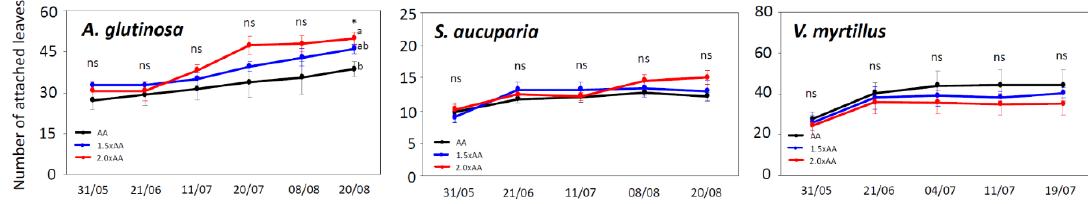
Figure 4. Number of attached leaves in Alnus glutinosa , Sorbus aucuparia, and Vaccinium myrtillus exposed to three levels of O 3 concentration (AA, ambient O 3 concentration 1.5 × AA, and ambient O 3 concentration 2.0 × AA). The points represent mean ± S.E. ( n = 3 plots). Asterisks show the significance of ANOVA tests: * p < 0.05 and ns, not significant. Different letters show significant differences among treatments in each date ( p < 0.05, Tukey test).